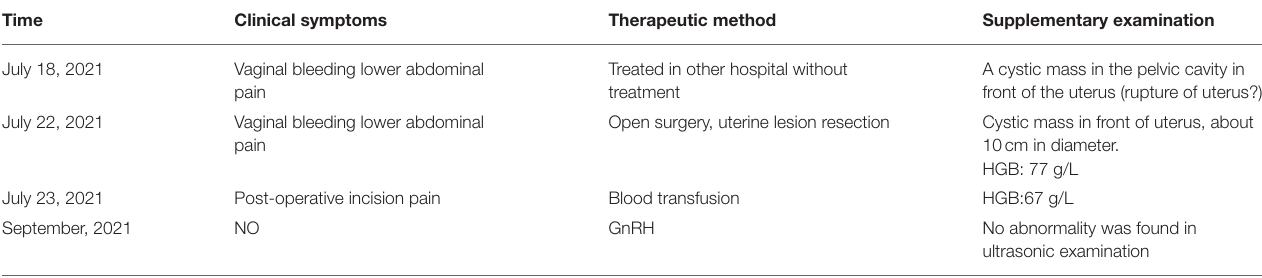
TABLE 2 | Patient diagnosis and treatment